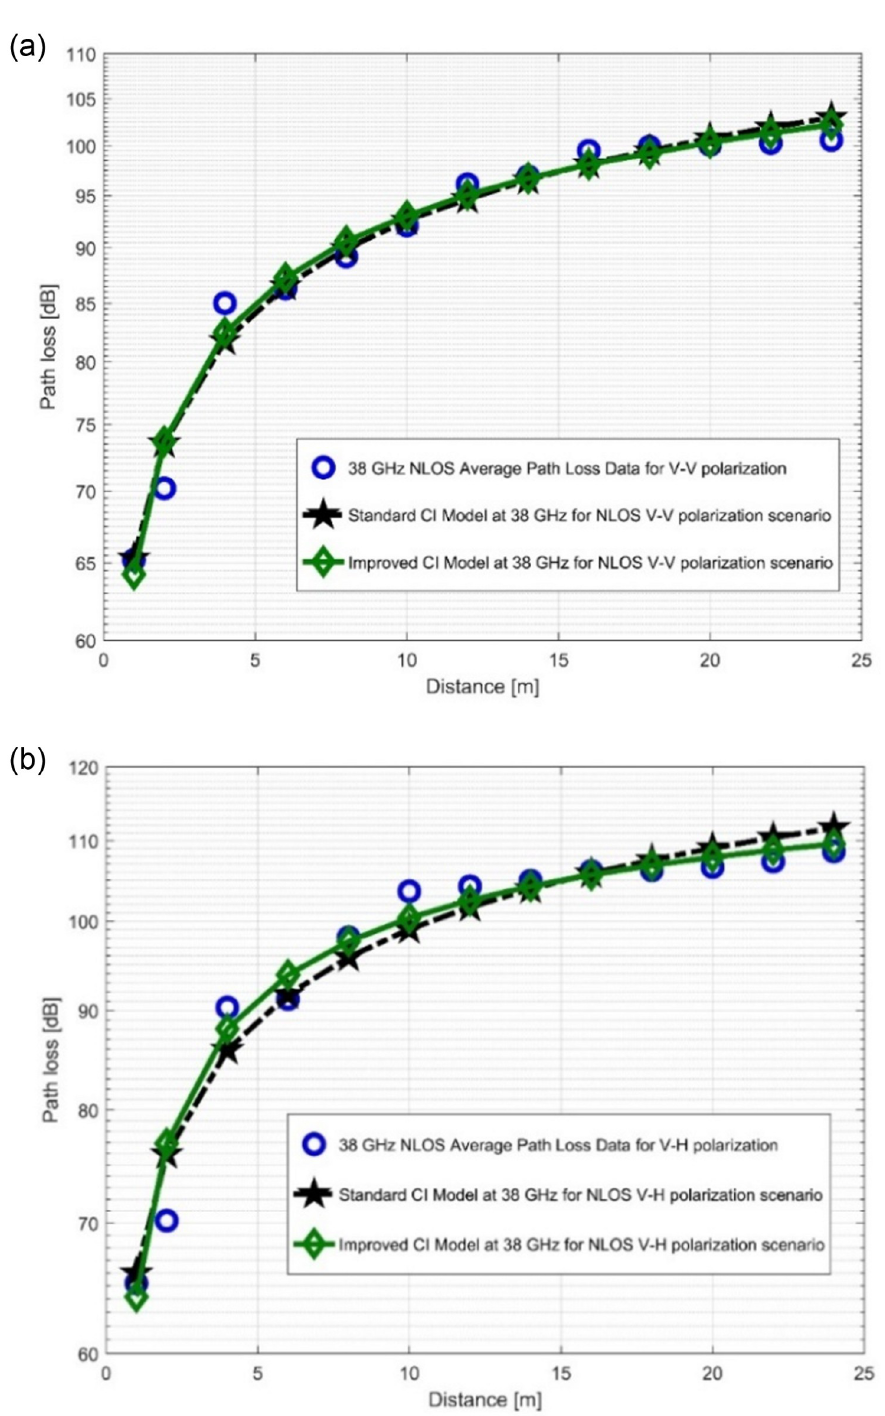
Fig 11. PL vs distance at 38 GHz for the NLOS scenario at (a) V-V polarization, (b) V-H polarization.